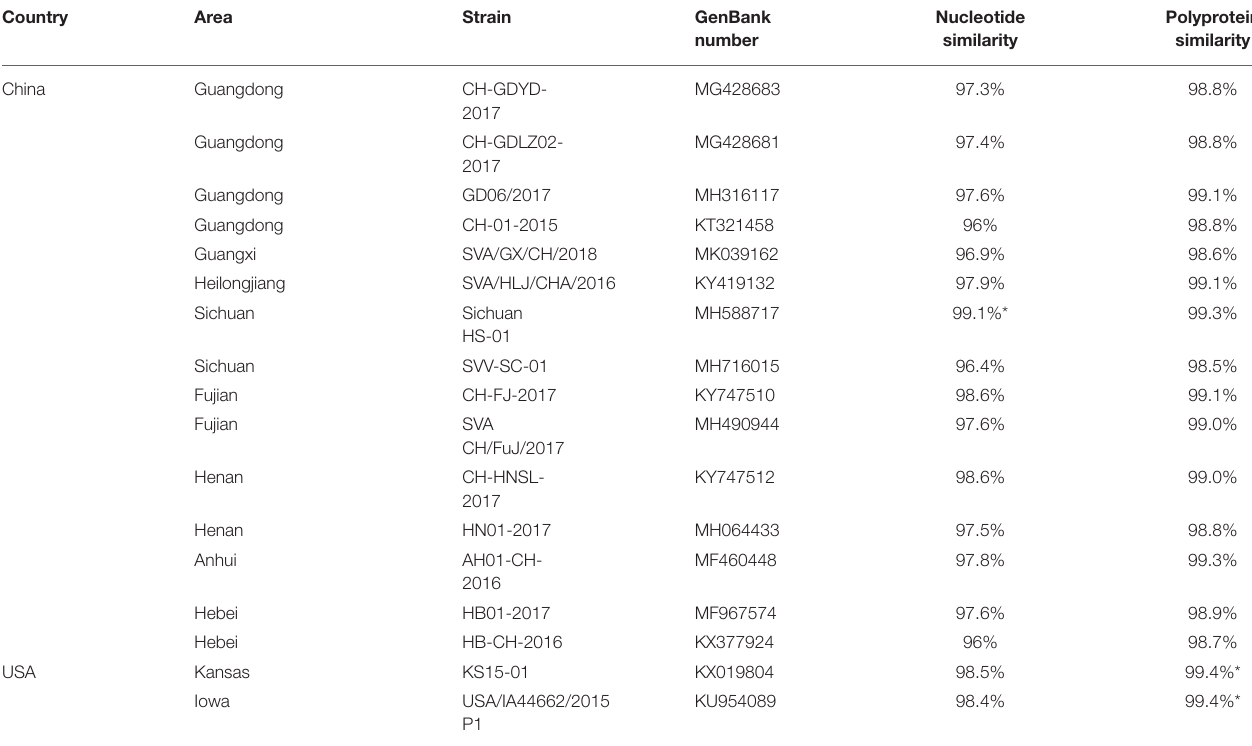
TABLE 2 | Partial nucleotide and amino acid percentage identities of the SVA/GD/China/2018 strain compared with other SVV strains. Country Area Strain GenBank